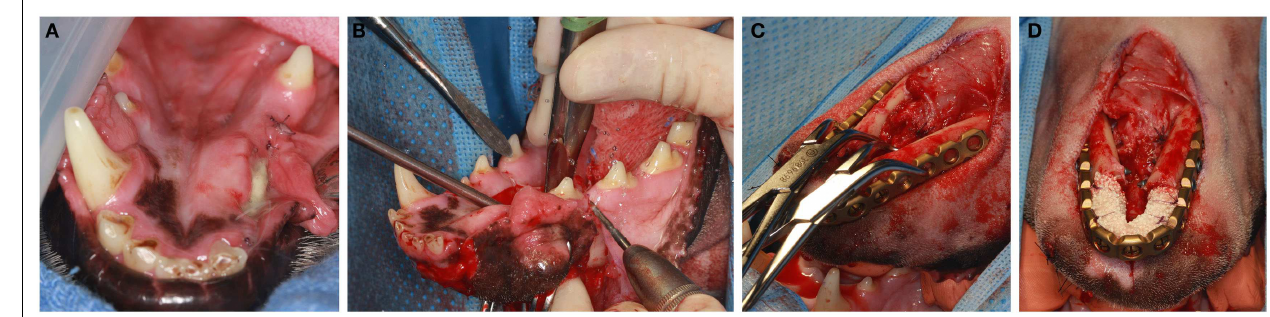
plate adaptation (C) . Once the plate is secured with titanium locking screws, the CRM infused with rhBMP2 is implanted in the defect and secured to the plate (D)